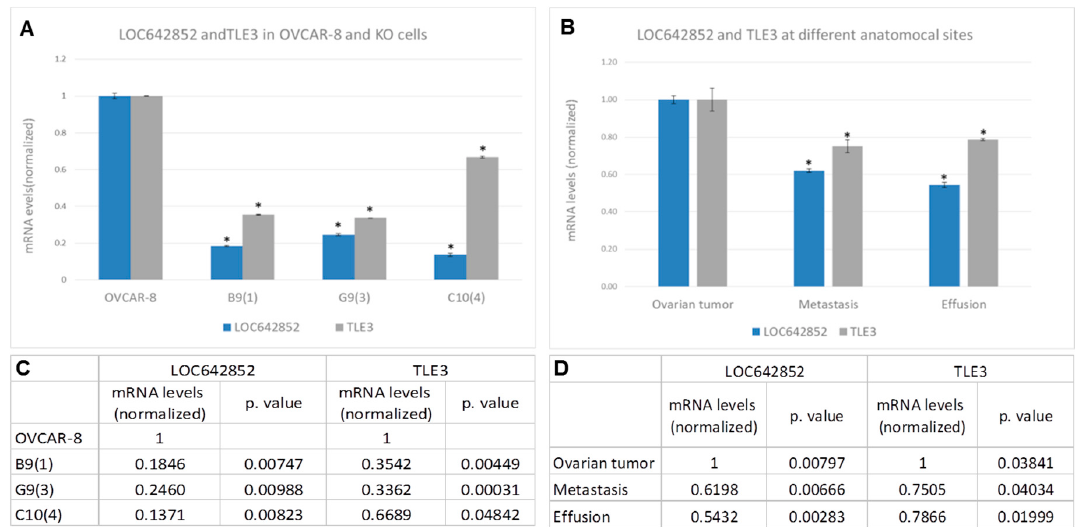
Figure 5. LOC642852 partners. ( A ) Graph showing mRNA levels of LOC642852 and family member 3, transcriptional corepressor (TLE3) in OVCAR-8 control cells and KO cells. ( B ) Graph showing mRNA levels of LOC642852 and TLE3 at different anatomical sites in clinical ovarian cancer (OC) specimens. Each site is a pool of 24 patient samples (* significant p -value). ( C , D ) detailed table of mRNA expression levels and p -values for graphs A and B, respectively.